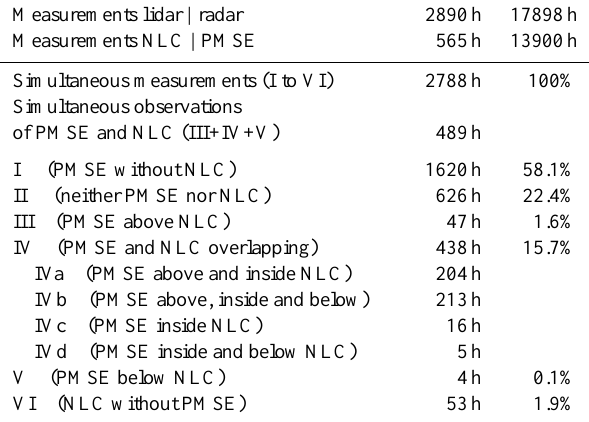
Table 1. Statistics of PMSE and NLC measured by the ALWIN radar and ALOMAR RMR lidar in the years 1999–2008. The com- bined dataset (“simultaneous measurements”) is split into cases I to VI regarding the occurrence of PMSE and/or NLC. Overlapping layers (case IV) are further split regarding their altitude